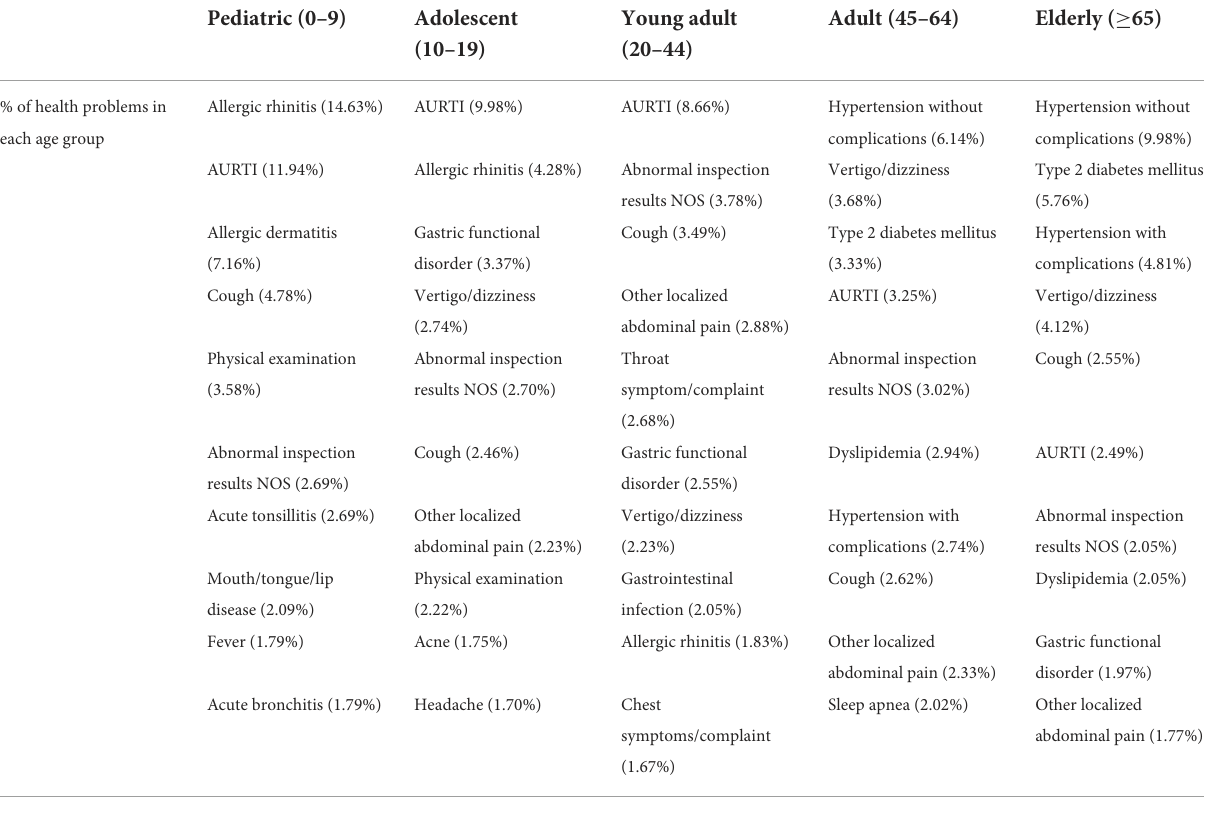
TABLE 4 Top 10 health problems in each age group.